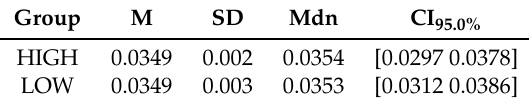
Table A3. EO HIGH and LOW stress-susceptible groups’ TEs. Mean (M), standard deviation (SD), median (Mdn), and 95.0% confidence interval (CI 95.0% ) associated with bootstrap (10,000 simulation runs) 95.0% confidence interval of upper bound CI of participants’ TEs (i.e., TE values associated with p < 0.025).